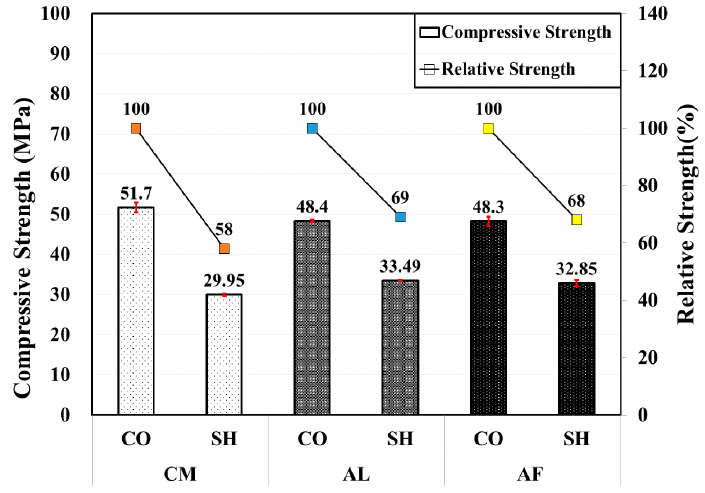
Figure 3. Compressive and relative strength by accelerators for 1-month-old specimens.